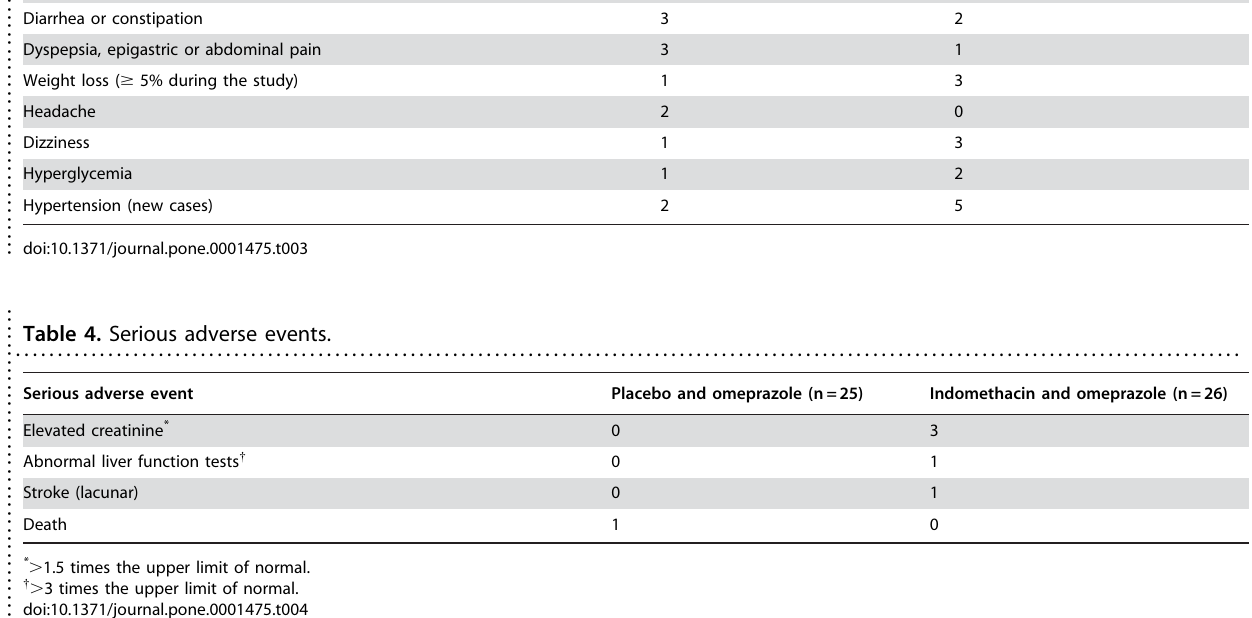
Table 3. Adverse events that occurred in at least two patients in either treatment group. .. ... .... ... ... .... ... ... .... ... ... .... ... ... .... ... ... .... ... ... .... ... ... .... ... ... .... ... ... .... ... ... .... ... ... .... ... ... .... ... ... .... ... ... . Adverse event Placebo and omeprazole (n=25) Indomethacin and omeprazole (n=26) Nausea 0 2 Diarrhea or constipation 3 2 Dyspepsia, epigastric or abdominal pain 3 1 Weight loss ( $ 5% during the study) 1 3 Dizziness